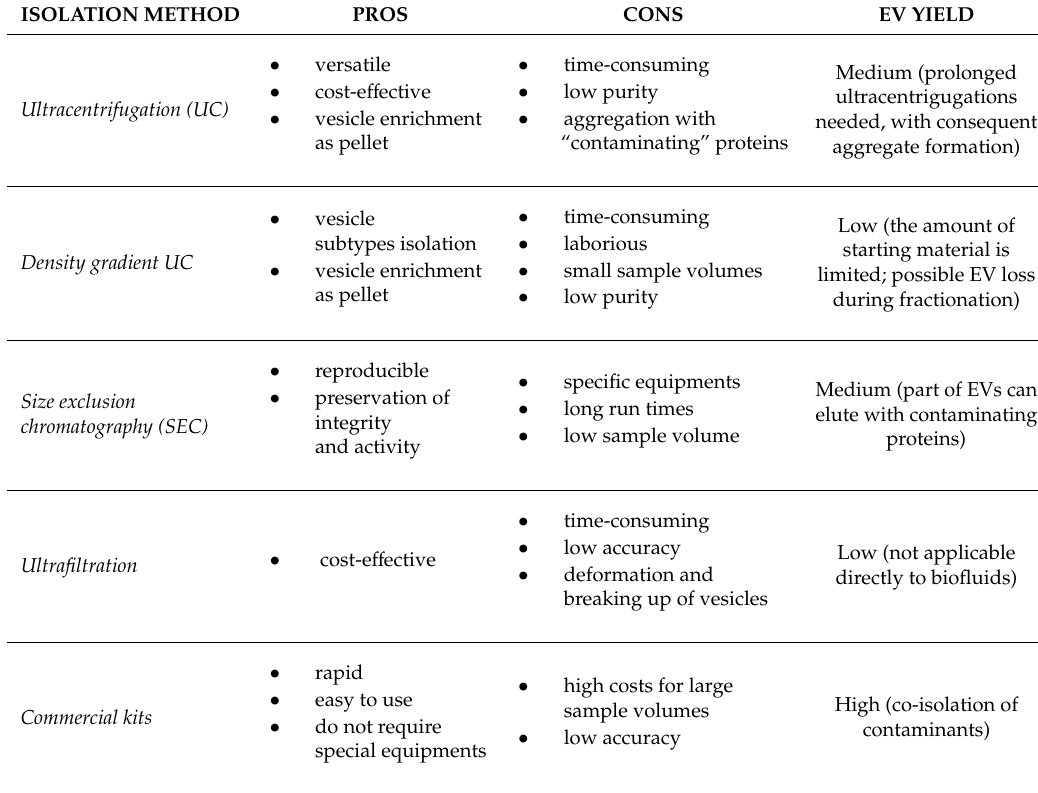
Table 1. Advantages and shortcomings associated with the most-commonly used isolation methods of biofluid-derived